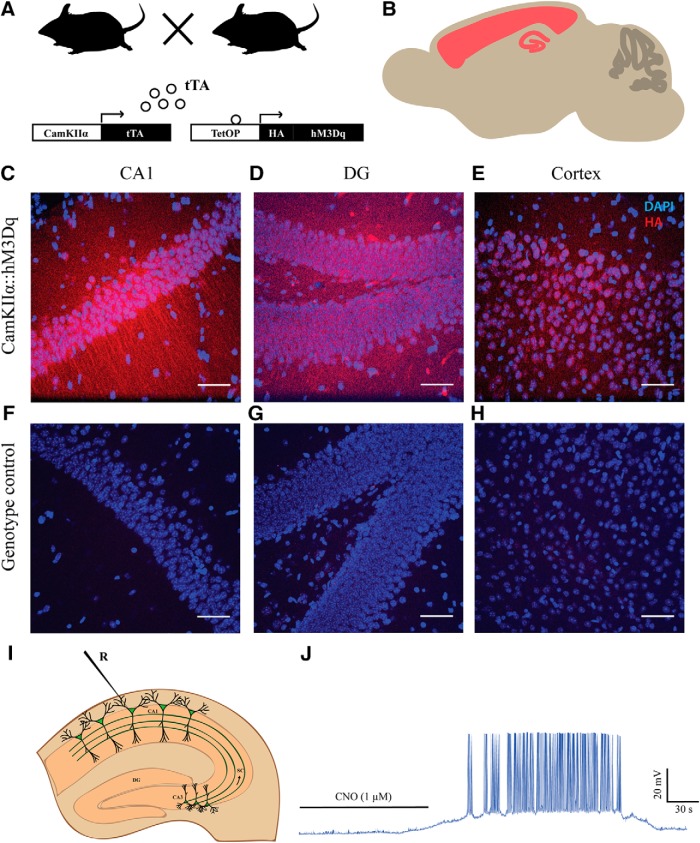

Selective expression of hM3Dq DREADD in forebrain excitatory neurons. A, Shown is a schematic of experimental strategy. hM3Dq DREADD was selectively expressed in the CamKIIα-positive excitatory neurons in the forebrain. tTA: tetracycline transactivator. B, Shown is a schematic of the extent of expression. Representative confocal images showing expression of hM3Dq identified by fluorescent immune-staining of HA-tag in the CA1 (C), DG (D), and cortex (E). No HA-tag immunoreactivity was observed in the genotype-control animals (F–H). Blue: DAPI; red: HA-Tag. Scale bar = 50 μm. I, Shown is a schematic showing whole-cell patch-clamp recording from the somata of CA1 pyramidal cells. J, Bath application of CNO (1 μM) resulted in robust spiking activity of CA1 pyramidal neurons. Refer to Extended Data Fig. 1-1 for spiking activity following bath application of 20 μM CNO. R: recording electrode.